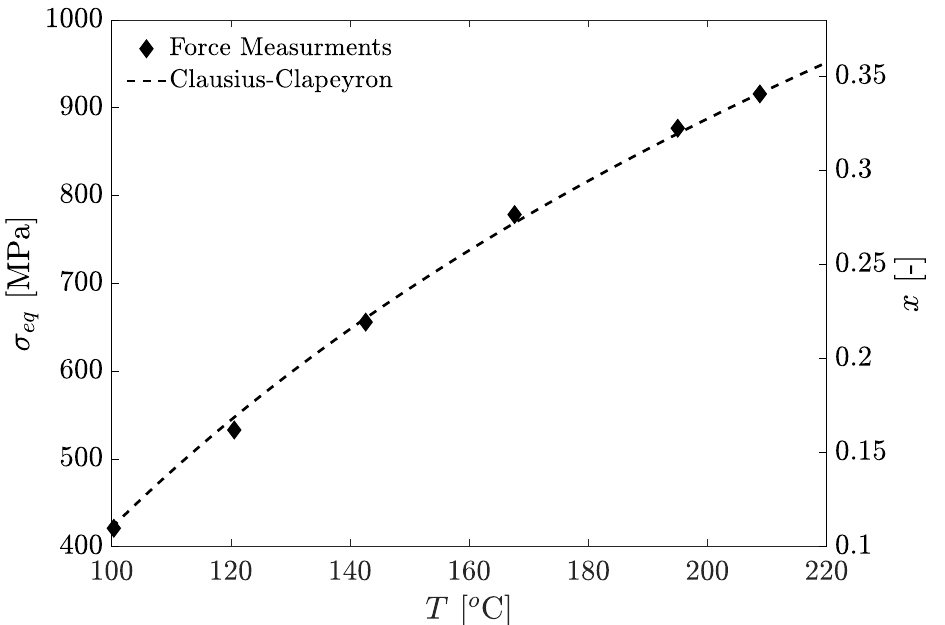
Figure 8. Equilibrium stress, σ eq (left axis), as a function of temperature for experiments performed on a wire with a diameter of 0.2 mm and a length of 48 mm (the same as shown in Figure 7). In all tests, the initial stress was set to σ 0 = 200 MPa. The corresponding austenite volume fraction, x eq (right axis), for each point, was calculated using Equation